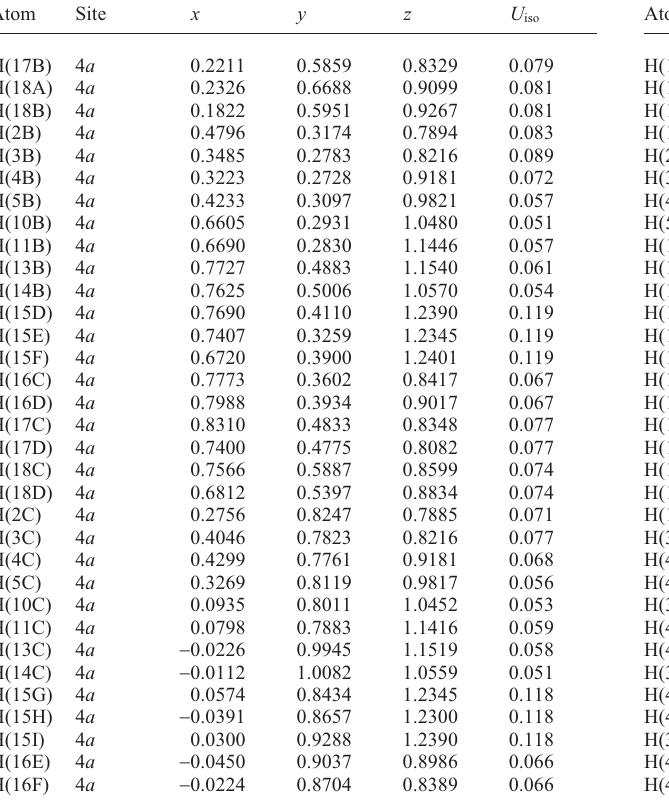
Table 3. Atomic coordinates and displacement parameters (in Å 2 )